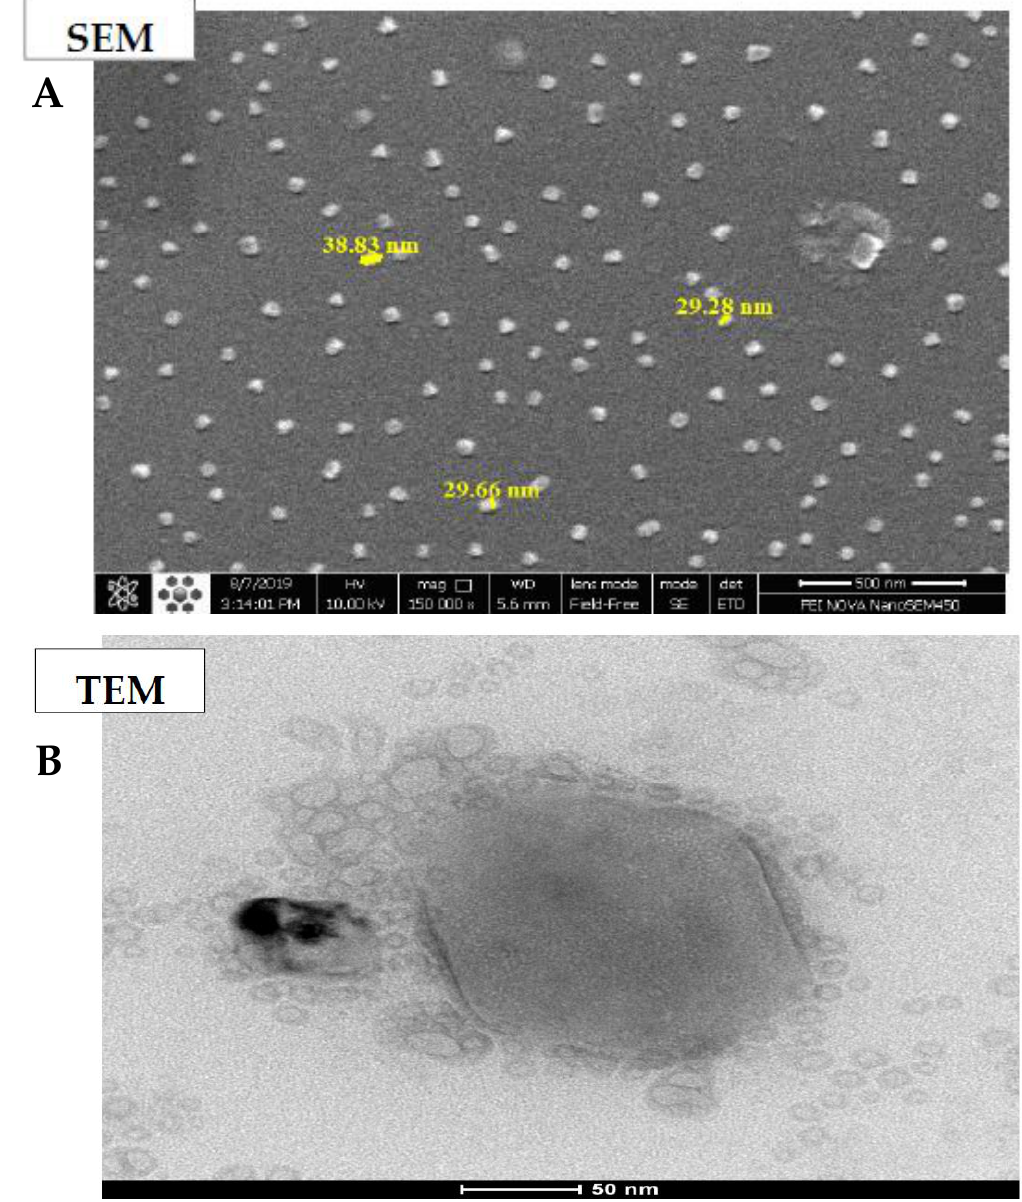
Figure 4. Morphological determination of AL-NioC. ( A ) scanning electron microscopy (SEM), and ( B ) transmission electron microscopy (TEM).